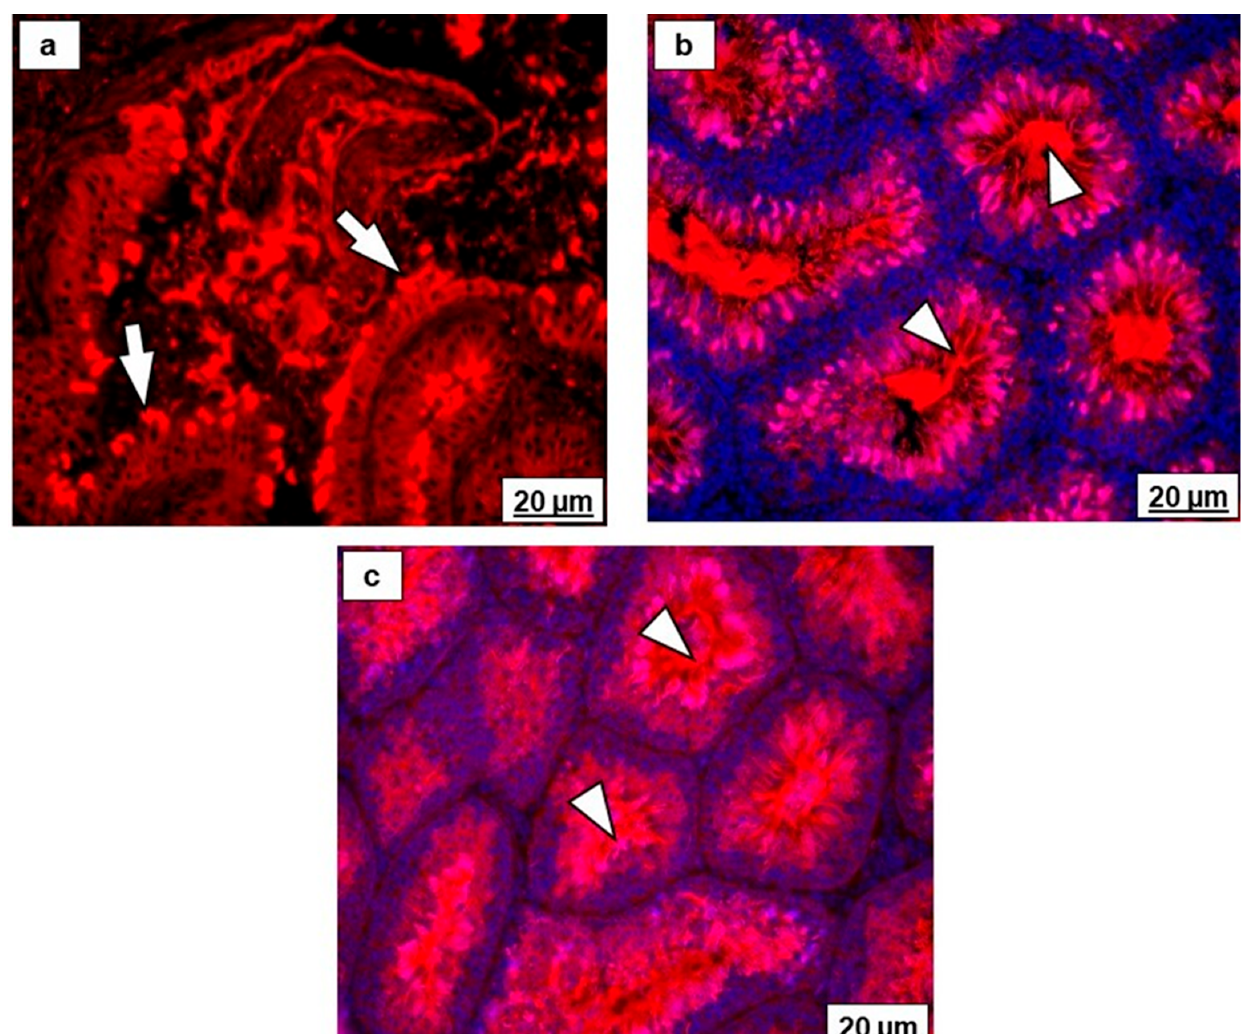
Figure 8. Immunofluorescence of beta-tubulin-Cy3 antibody in the ( a ) efferent ducts, ( b ) testis of an adult Japanese quail, and ( c ) chicken testis ( n = 1 per animal). ( a – c ) Red signal- beta-tubulin immunostaining in the cilia of efferent ducts epithelium (white arrows) and spermatozoa of the testis (white arrowheads). ( b , c ) Immunostaining with 4 ′ , 6-diamidino-2-phenylindole dihydrochloride (DAPI) in nuclei of the testicular epithelia (blue signal).